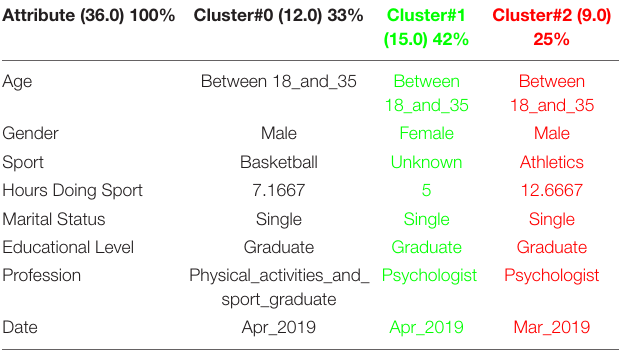
TABLE 5 | 3 clusters POMS analysis for March to May 2019.